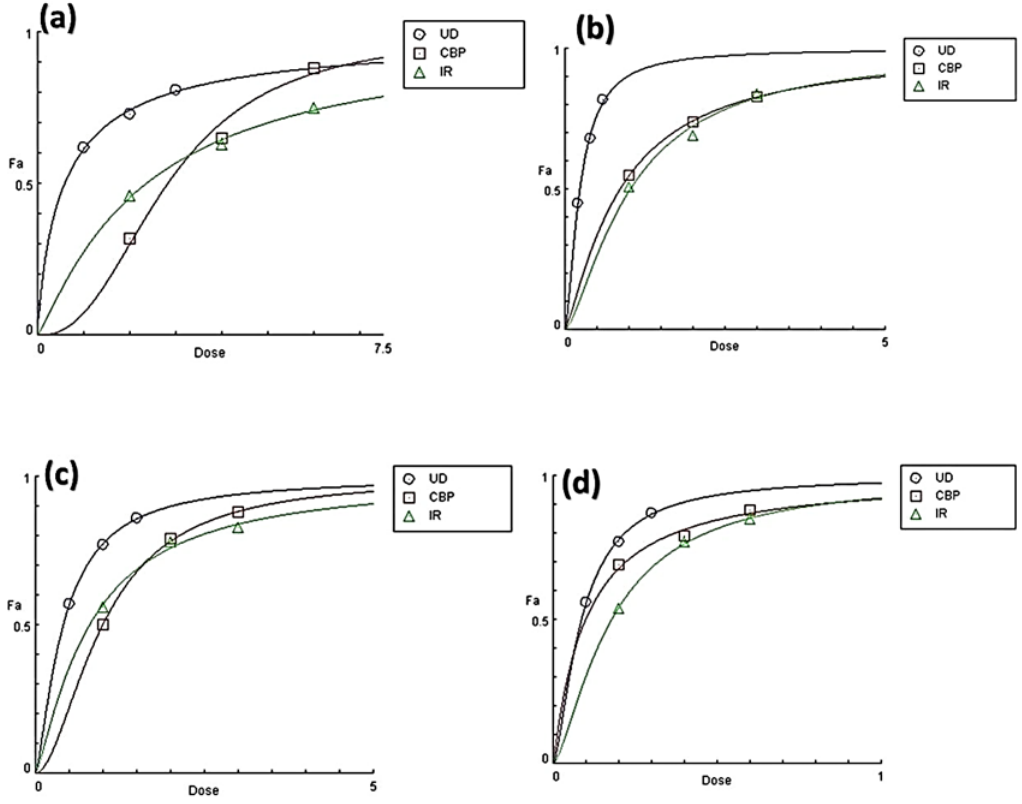
Figure 4. Dose effect curves of aqueous ( a , c ) and ethanolic ( b , d ) Urtica dioica (UD), Capsella bursa-pastoris (CBP), and Inula racemosa (IR) using DPPH and ABTS radical scavenging models. All three extracts, UD, CBP and IR, showed a dose-dependent behavior. With the increasing concentration, the DPPH and ABTS radical scavenging activities increased significantly. Data are shown as the mean ± SD for n = 3. p < 0.05 was considered statistically significant.